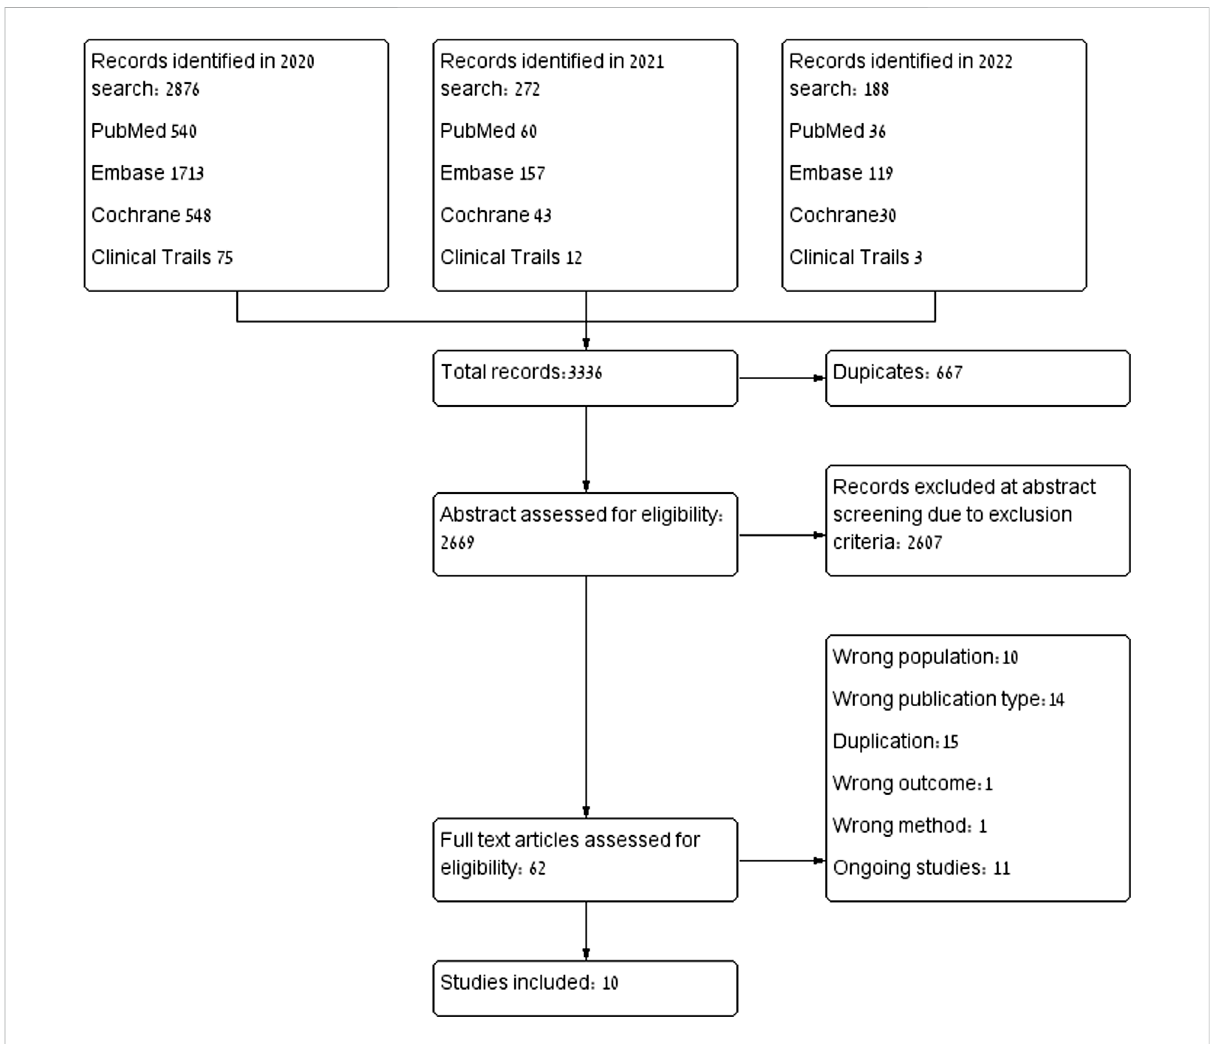
FIGURE 1 Publication selection